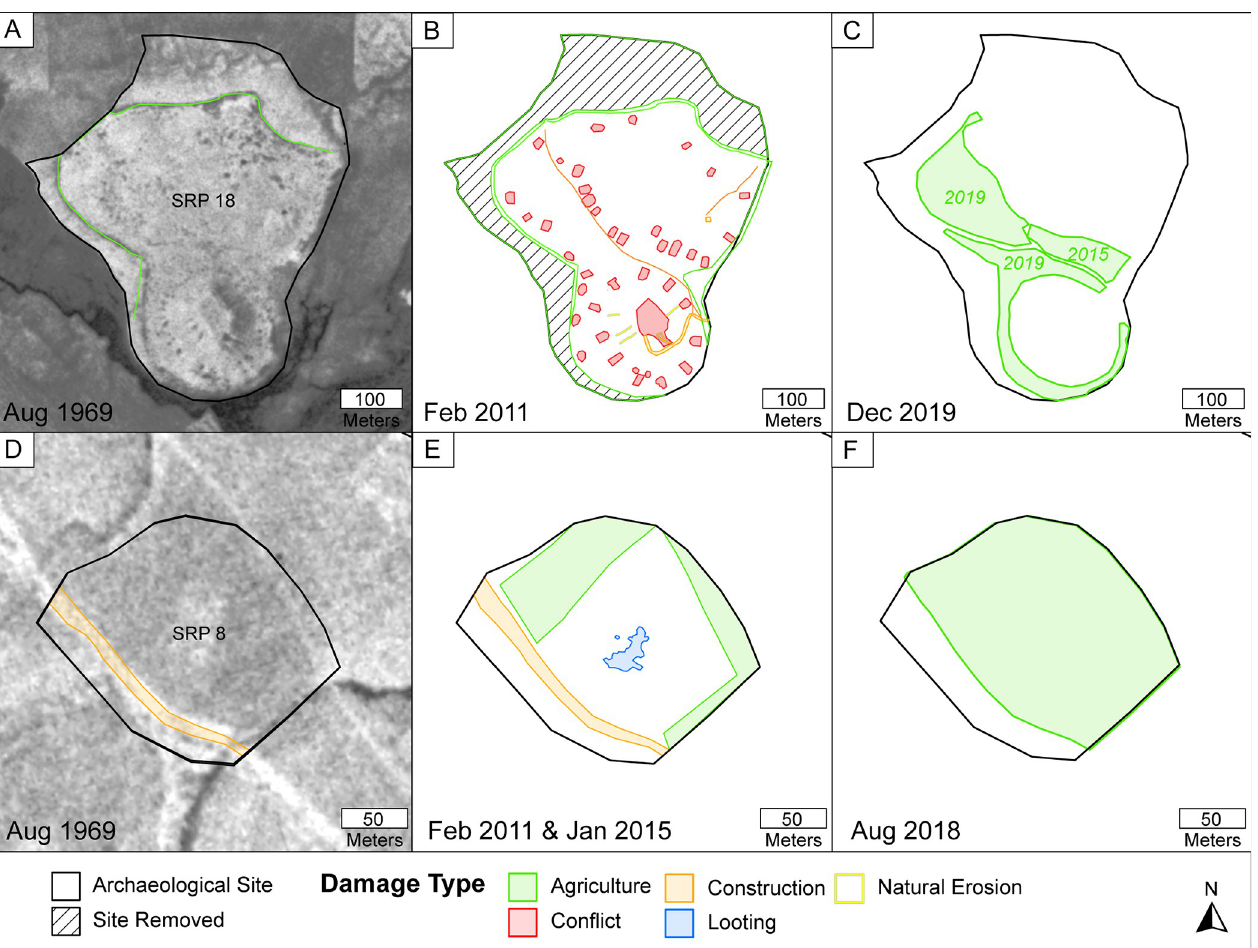
Fig 6. Damage assessments of Tepe Kalan (SRP 18; A–C) and SRP 8 (D–F). (A, D) August 1969 CORONA imagery (courtesy USGS and CORONA Atlas). See Fig 1 and CORONA Atlas URL links for site locations (SRP 18: https://corona.cast.uark.edu/atlas#zoom=17&center=5025288,4089876; SRP 8: https://corona. cast.uark.edu/atlas#zoom=18&center=5024420,4101263). (B–E) Damage assessments completed on 2011 Worldview-2 imagery. (C, F) Damage assessments reflecting post-2011 damage including new instances of agricultural ploughing that have obscured damage visible in earlier imagery (semi-transparent green areas). See Google Earth Pro (http://www.earth.google.com [accessed Feb 17, 2022]) for (C) December 2019, (E) January 2015, and (F) August 2018 imagery.